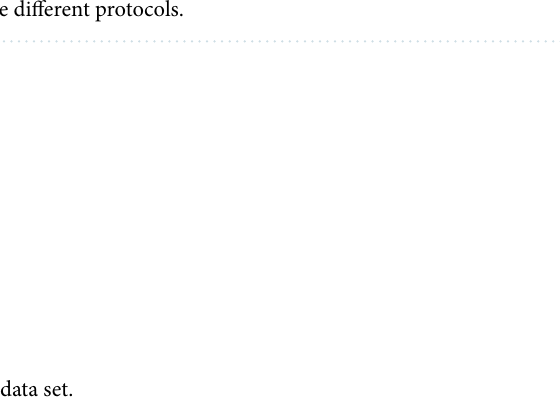
Table 3. Overview of the clinical protocols. Images were acquired on the Philips Gemini TF64 PET/CT (previously referred to as scanner 2) with three different protocols.